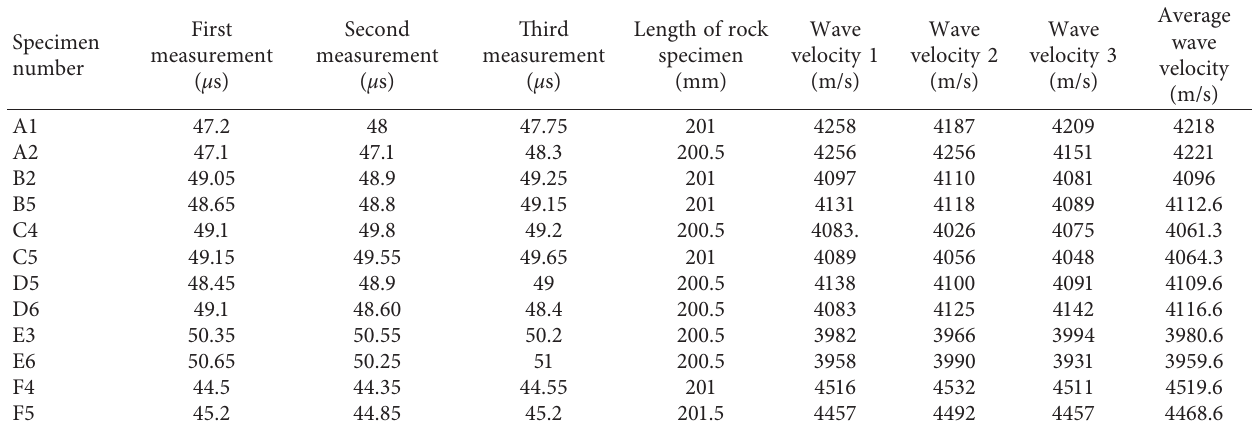
Figure 8: Process of obtaining rock specimens: (a) the six rock blocks after drilling center holes; (b) after drilling parallel holes; and (c) rock specimens removed from rock Table 2: Test results of longitudinal wave velocity of rock specimens.